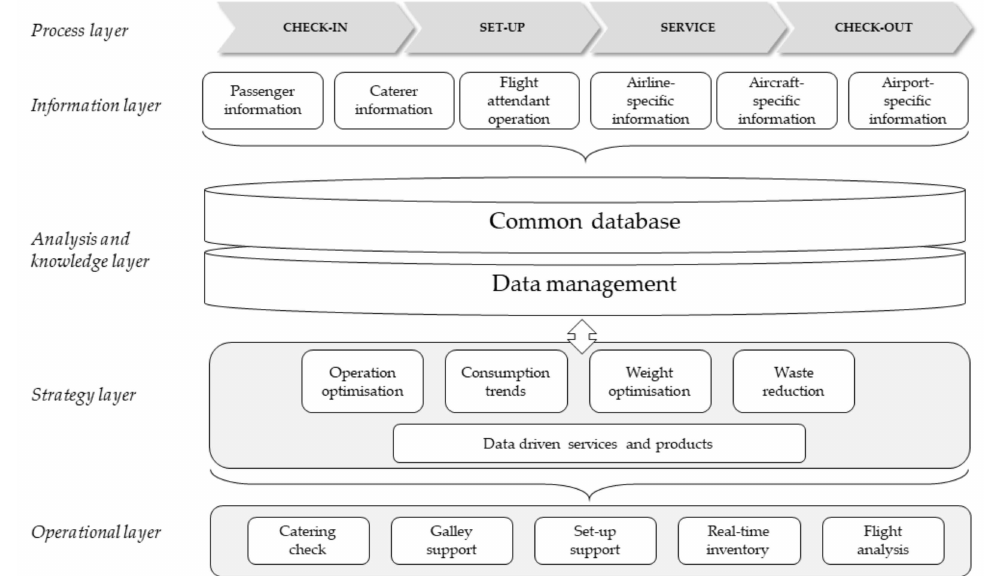
Figure 14. Reference architecture for digitising the inflight catering